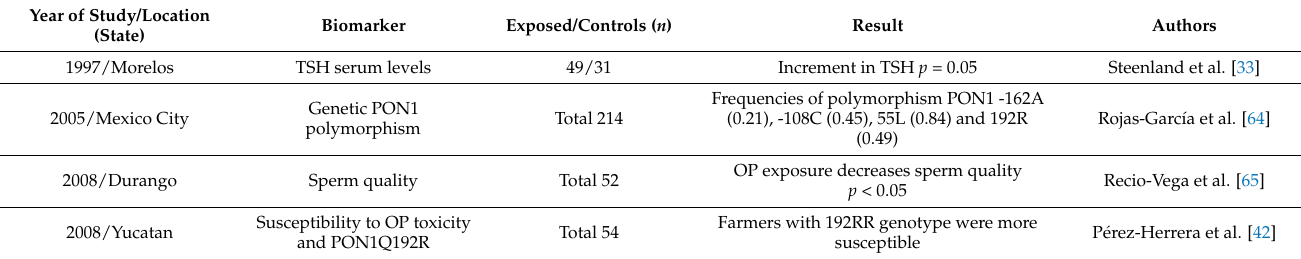
Table 2. Studies developed in Mexico on biomarkers susceptibility in populations exposed to